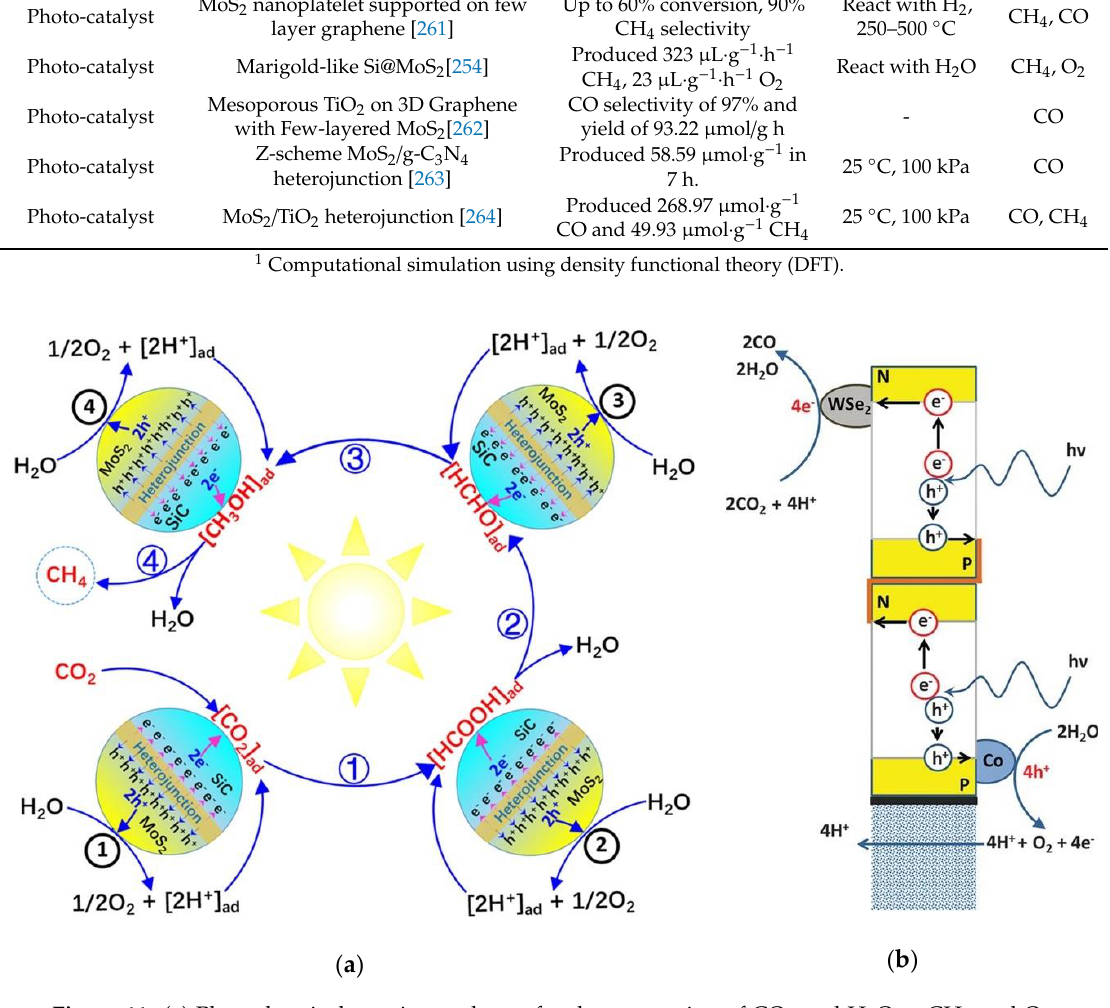
Figure 11. ( a ) Photochemical reaction pathway for the conversion of CO 2 and H 2 O to CH 4 and O 2 under visible light using SiC@MoS 2 nanoflower (Reproduced with permission from [254]. Copyright 2018 American Chemical Society) and ( b ) schematic of the WSe 2 -based artificial leaf cell design for the conversion of CO 2 and H 2 O to CO and H 2 (Reproduced with permission from [255]. Copyright 2016 The American Association for the Advancement of Science).